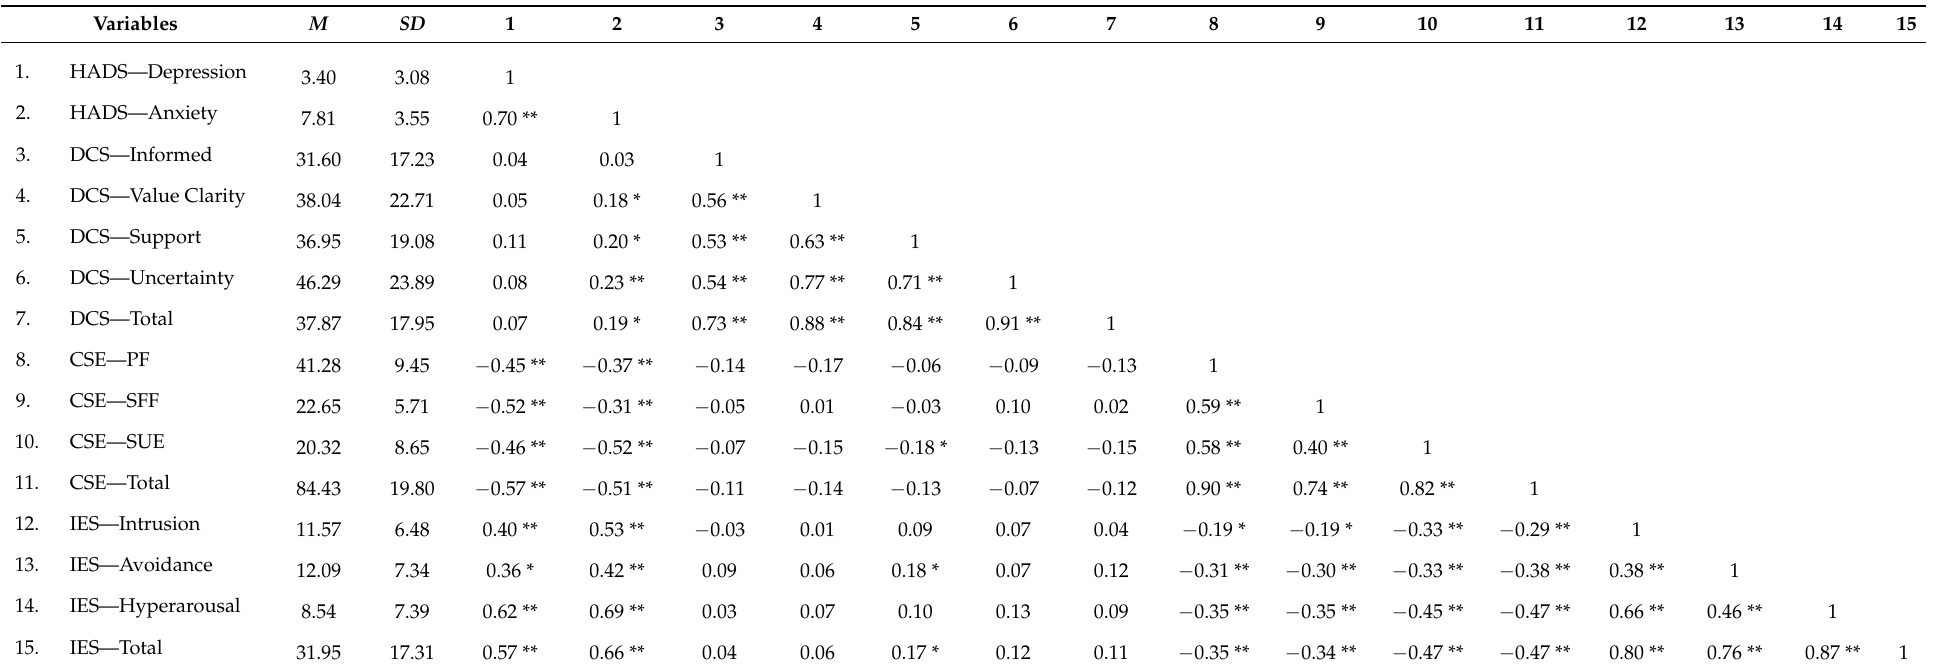
Table 2. Means, standard deviation, and correlations among all continuous psychological and decision-making